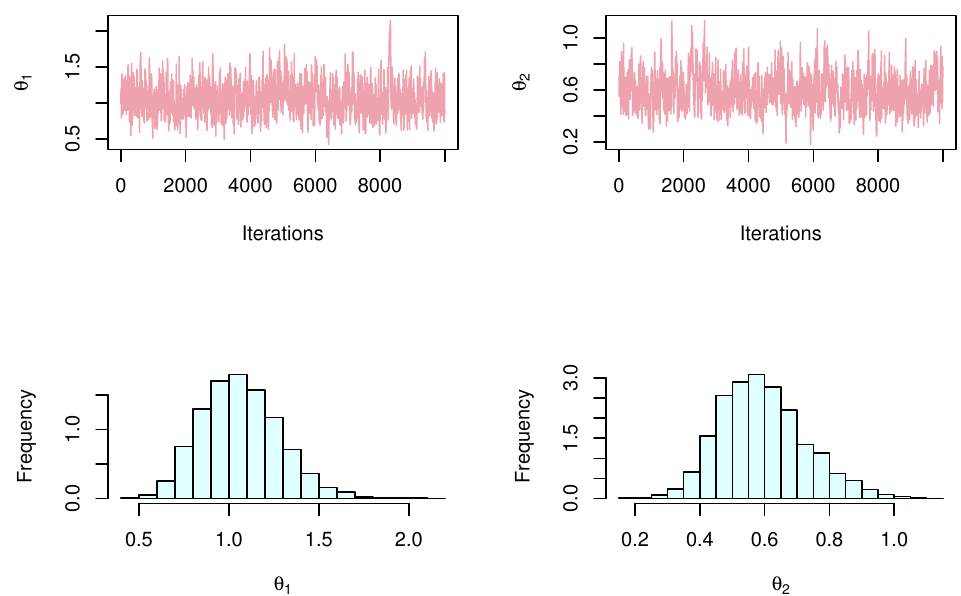
Figure 11. MCMC plots of parameter estimation by SRS method for failure times of insulating fluid data.